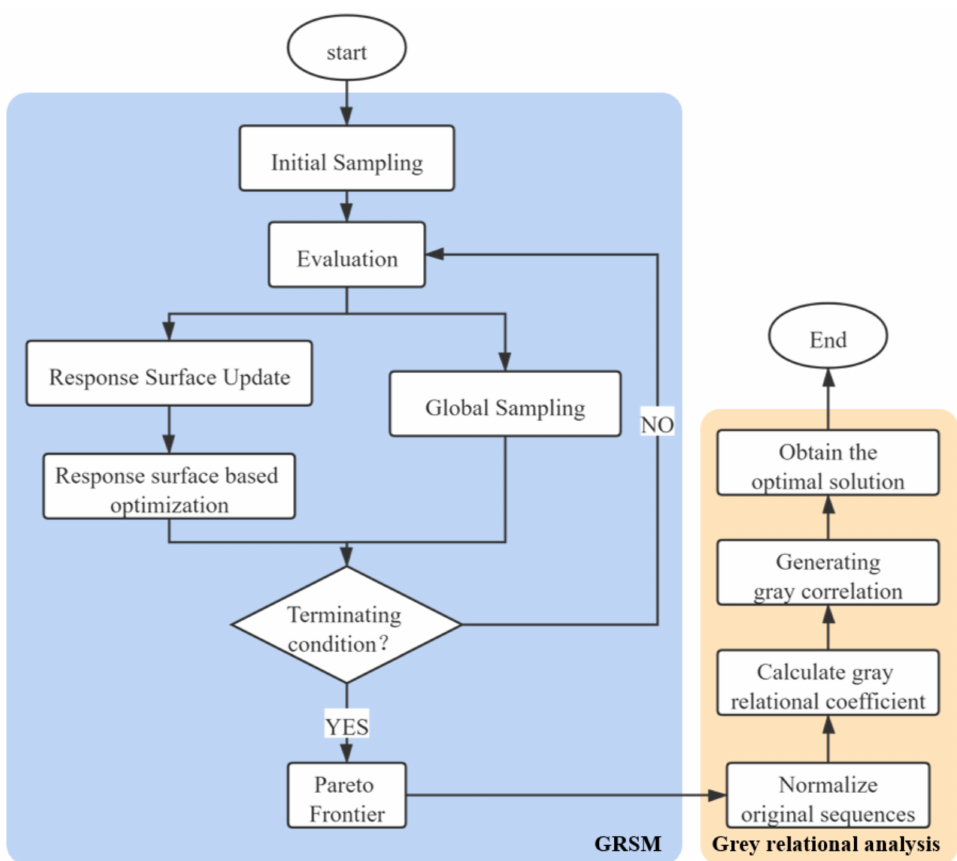
Figure 19. Flowchart of crashworthiness optimization for